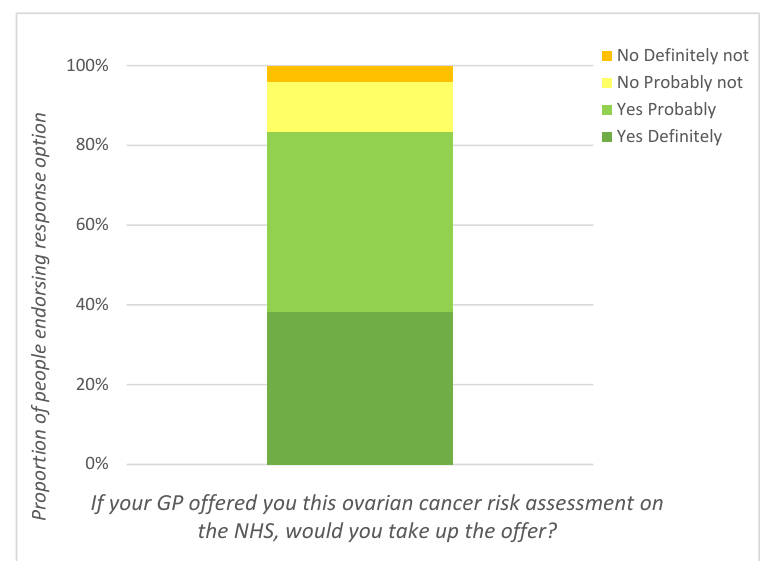
Figure 2. Interest in ovarian cancer risk assessment.